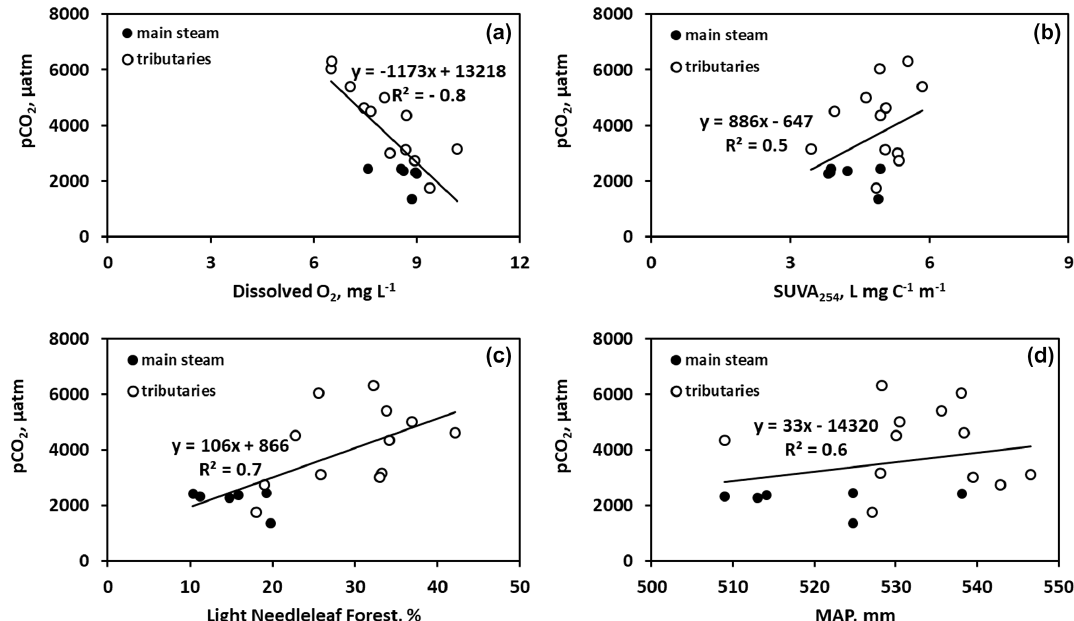
Figure 5. Significant ( p< 0 . 05) control of dissolved oxygen (a) , SUVA 254 (b) , light needleleaf forest (c) , and mean annual precipitation (d) on CO 2 concentration in the Ket River and tributaries during summer